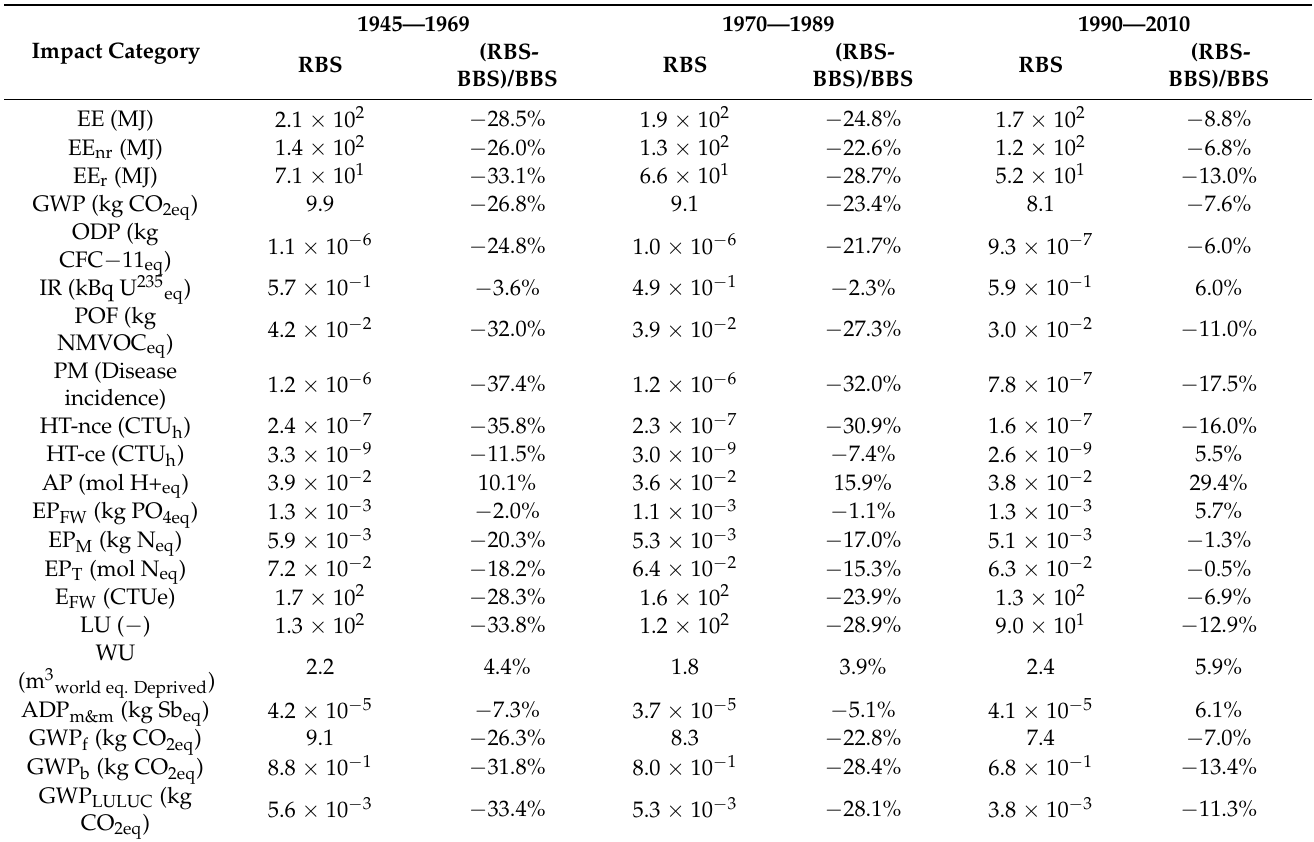
Table 6. LCIA—expanded system boundaries—stone wool scenarios (FUES: 1 m 2 of walkable floor per year). Impact